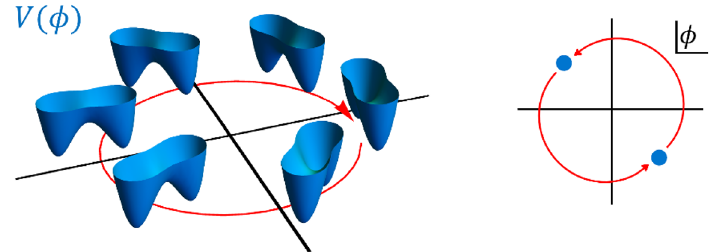
Figure 2 . A schematic example of vacuum crossing. On the left we plot a potential V ( (cid:30) ) at various points in parameter space. The key point to note is that if we follow one minimum around a circle in parameter space, we end up in the second minimum. On the right we plot the corresponding behavior of the vacua in the (cid:30) plane. The vacua are thus exchanged once we complete the loop in parameter